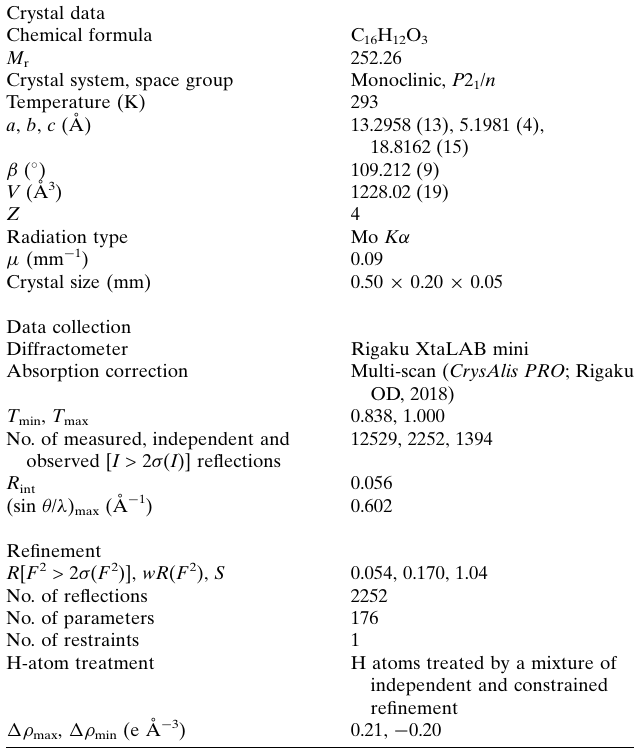
Table 2 Experimental details.